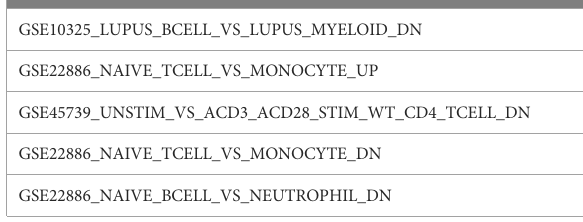
demonstrate the critical role that immune-related genes play in SCI (Figure 9B).